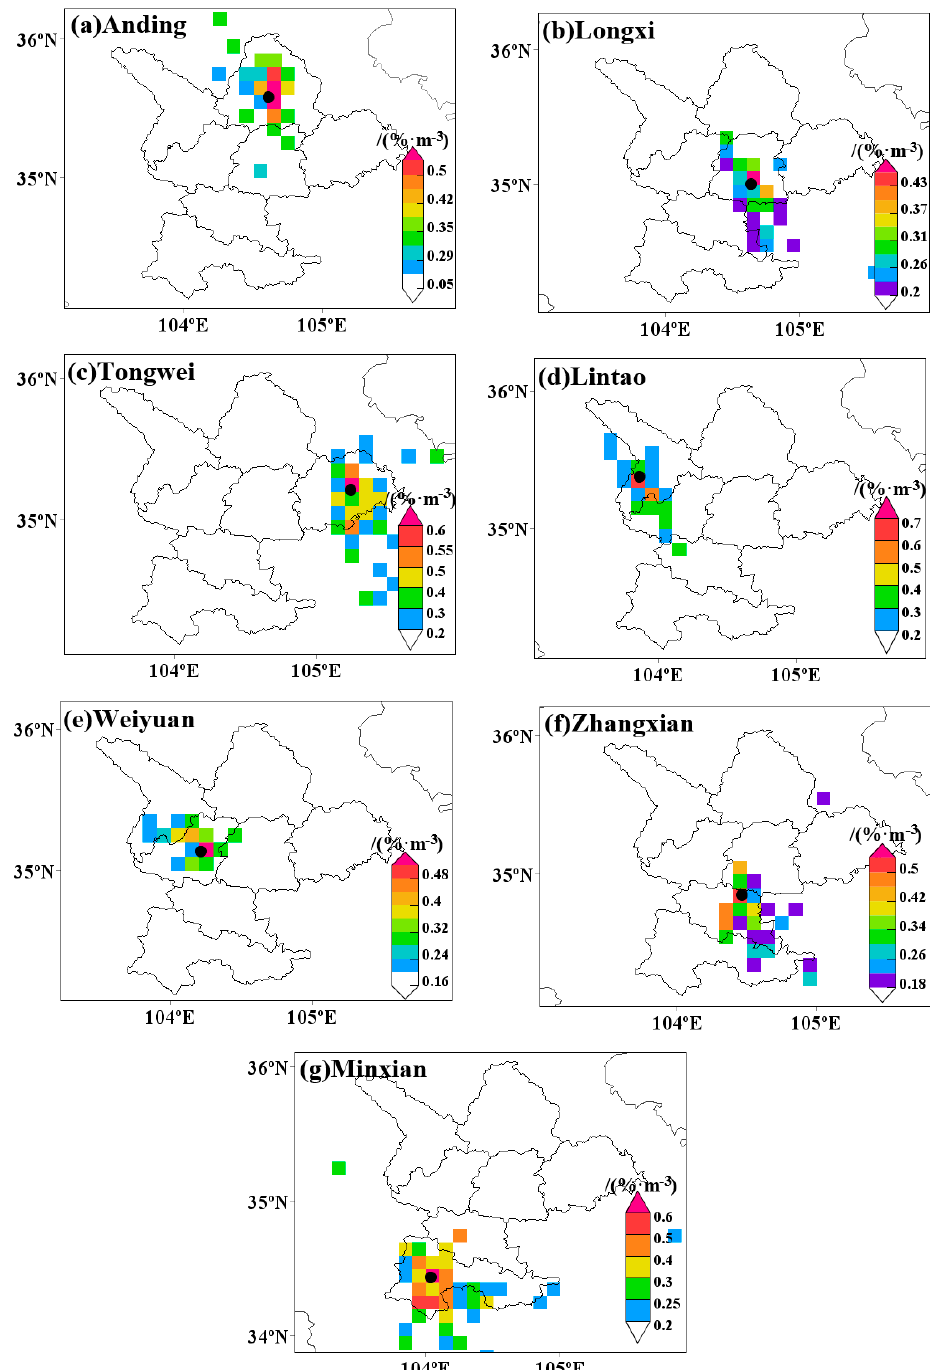
Figure 5. ( a ) Map showing the PSCF analysis of Anding sampling station in the study area during the monsoon period. ( b ) Map showing the PSCF analysis of Longxi sampling station in the study area during the monsoon period. ( c ) Map showing the PSCF analysis of Tongwei sampling station in the study area during the monsoon period. ( d ) Map showing the PSCF analysis of Lintao sampling station in the study area during the monsoon period. ( e ) Map showing the PSCF analysis of Weiyuan sampling station in the study area during the monsoon period. ( f ) Map showing the PSCF analysis of Zhangxian sampling station in the study area during the monsoon period. ( g ) Map showing the PSCF analysis of Minxian sampling station in the study area during the monsoon period.